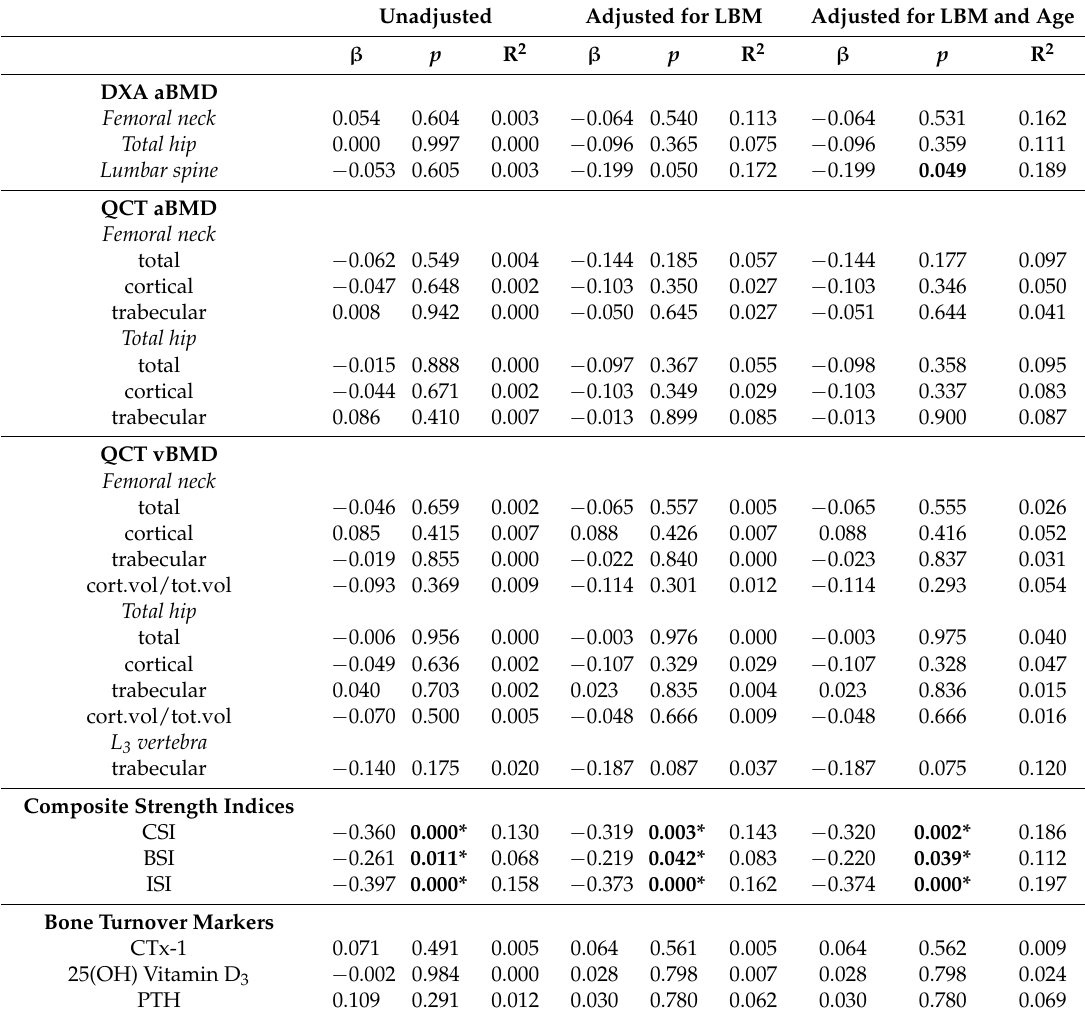
Table 2. Results of univariate and multivariate linear regression analysis between log 10 HOMA-IR and areal BMD (aBMD), volumetric BMD (vBMD), cortical bone ratio, Composite Strength Indices and blood